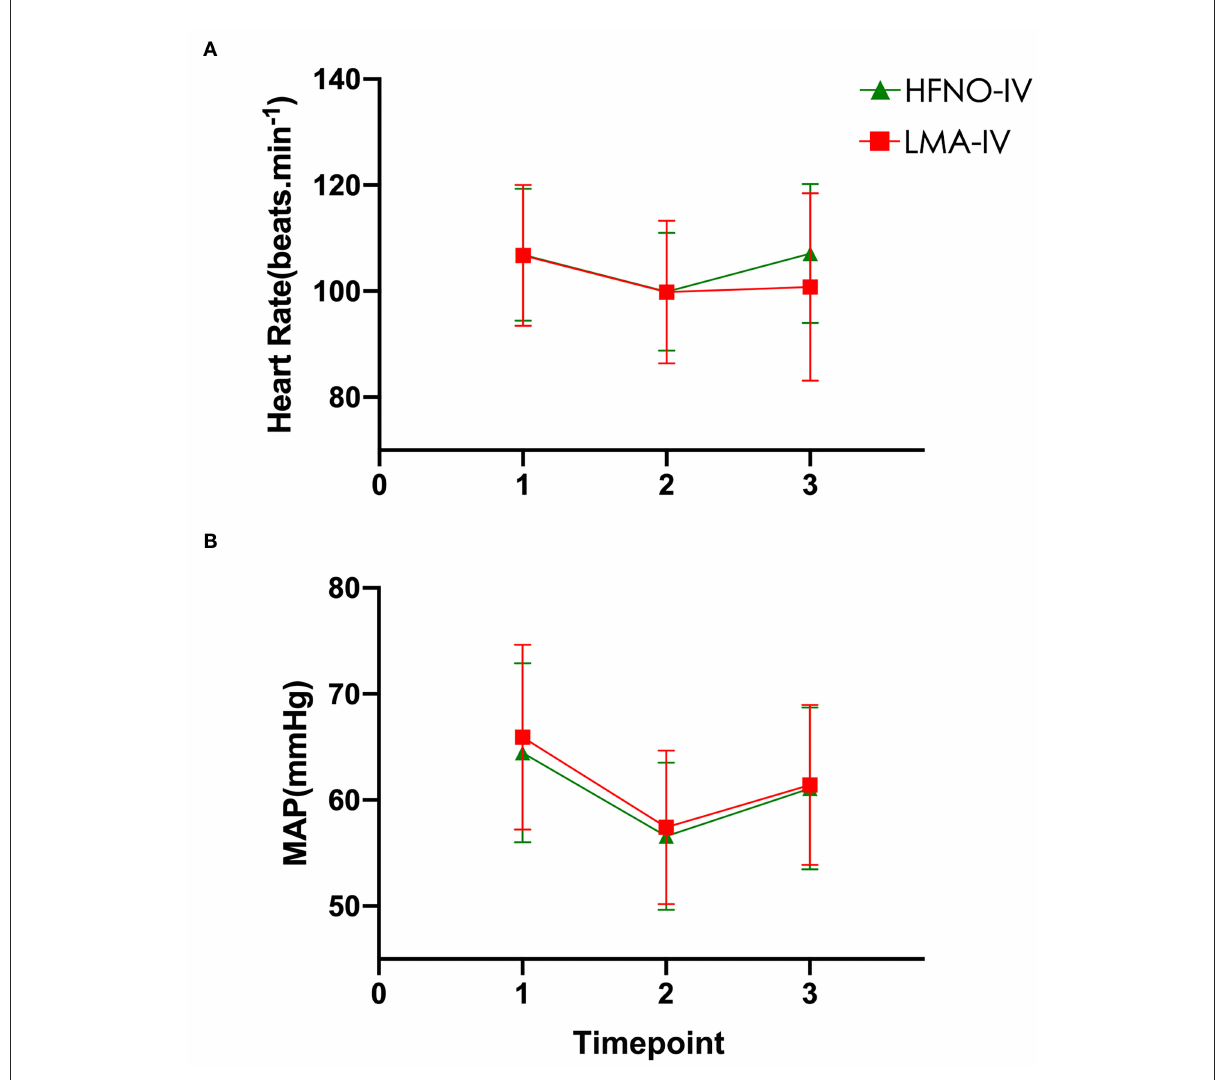
FIGURE3 (A,B) Heart rate and MAP at three